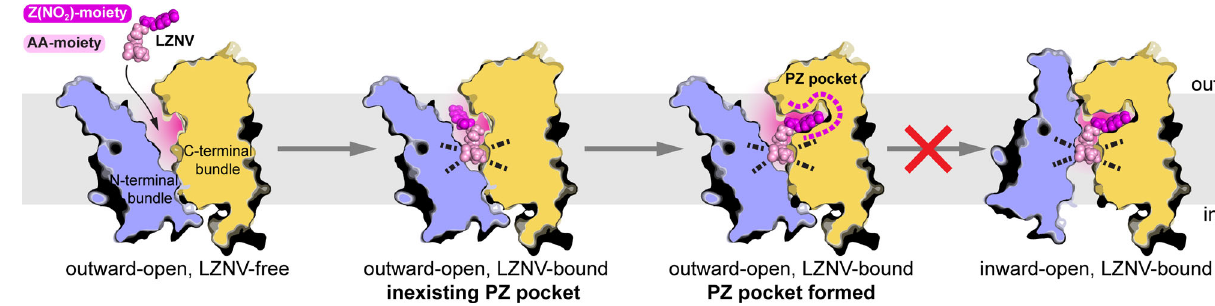
Fig. 7 Proposed proton-dependent oligopeptide transporter (POT) inhibition mechanism by LZNV. Cartoon of LZNV (dipeptide amino acid-moiety (AA- moiety): bright pink and Z(NO 2 )-moiety: dark pink) approaching a peptide transporter in the outward-open state followed by its partial and full binding. Notice that the PZ pocket is initially absent and forms after binding of the conserved dipeptide backbone to the protein. The Z(NO 2 )-moiety bound to the PZ pocket acts like a wedge impeding the transition to the inward-open state. LZNV-POT interactions are indicated by dotted lines. Whereas the grey bar represents the lipid bilayer, the N- and C-terminal bundles are coloured in blue and dark